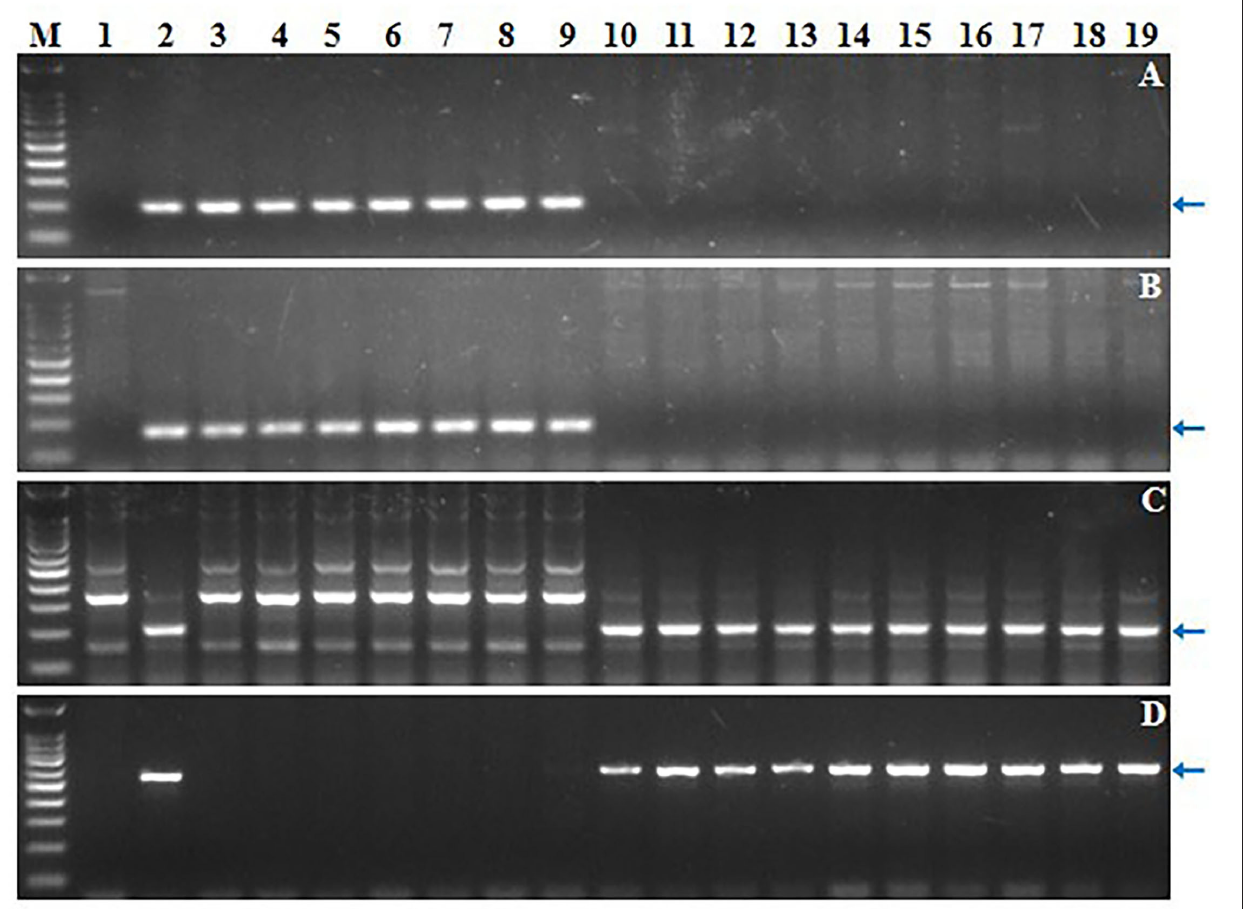
FIGURE 1 | Screening of 17 CS- Ae. longissima 6S l #3 RobTs by molecular marker analysis. (A–D) Electrophoresis patterns of 6S l #3-specific markers Ael69501, Ael67319, Ael63185 and Ael42958, respectively. M: 100 bp DNA Ladder Marker; 1: common wheat CS; 2: CS- Ae. longissima 6S l #3 disomic addition line TA7548; 3-19: the newly developed CS- Ae. longissima 6S l #3 RobTs and telosomes. Arrows pointed to the polymorphic bands of the chromosome 6S l #3-specific molecular